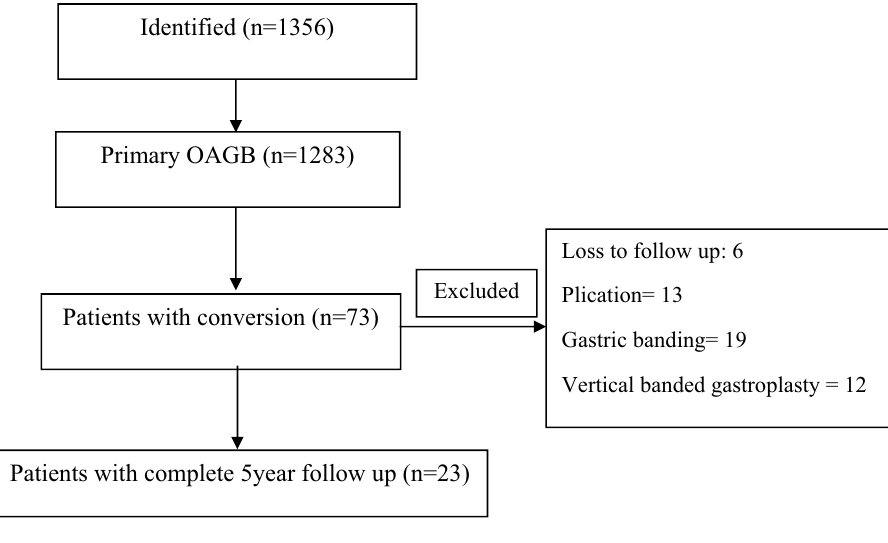
Figure 1. Flow chart of the patients participated in the